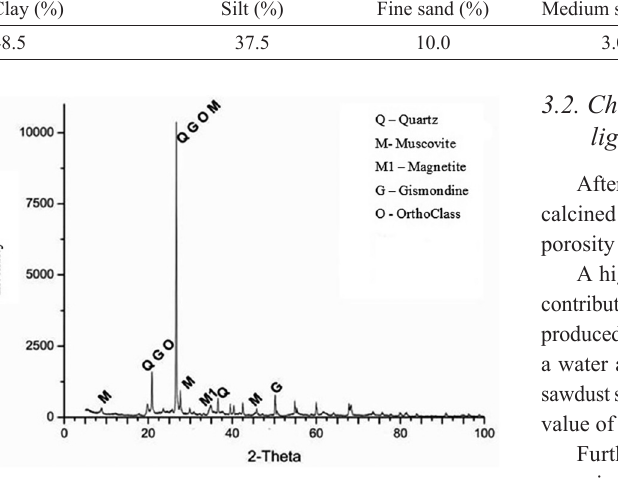
Figure 1: X-ray diffraction pattern.